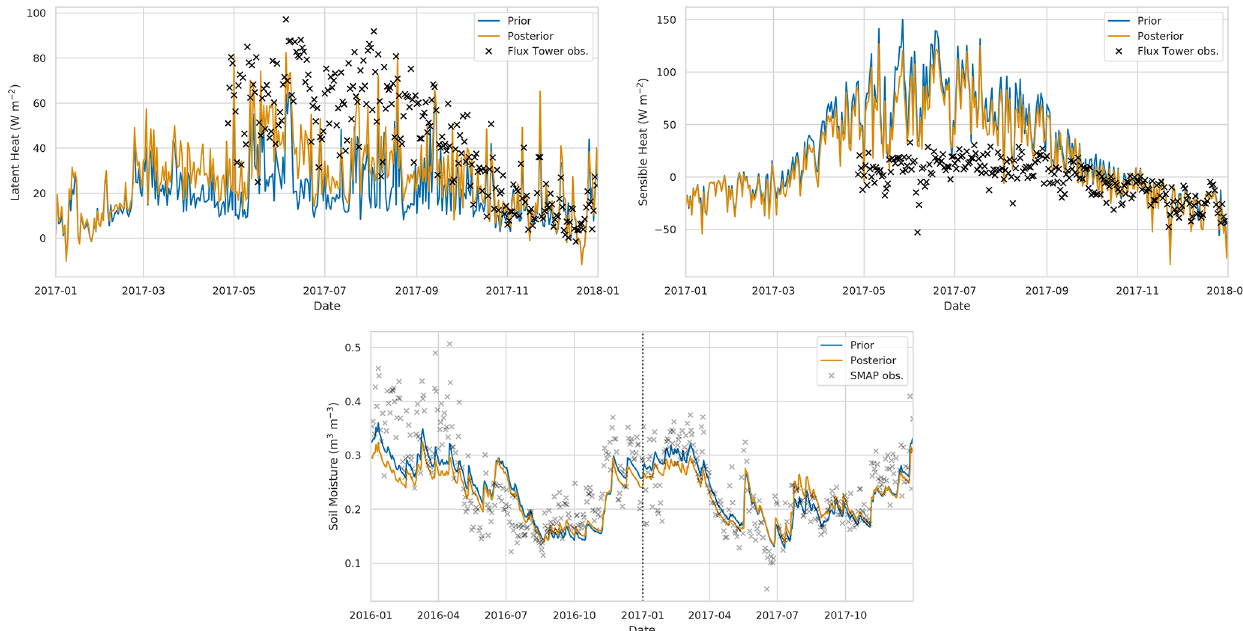
Figure 16. Time series of heat flux variables and soil moisture at Great Fen flux tower site. Black crosses: flux tower observations, grey crosses: SMAP observations for closest 9km pixel, blue line: prior JULES estimate for closest 1km grid cell, orange line: posterior JULES estimate for closest 1km grid